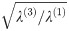
The third eigenvector components.For the entire period and all subperiods, we multiply the third eigenvector components by λ(3)/λ(1) and observe two large clusters, one containing most of the European currencies and the other the Asian, South American, and Middle Eastern currencies, largely dominated by the US dollar. Note that here the correlations among stock market indices are almost non-existent.